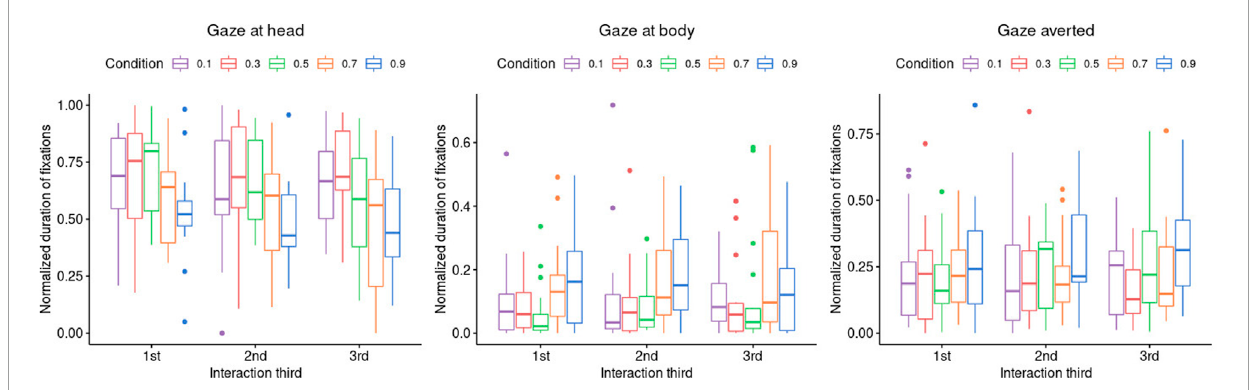
FIGURE 6 Normalized fixation durations for variable ROIs, head (left), body (middle), and gaze averted (right), for the between-factor GAR condition and the within-factor interaction third.